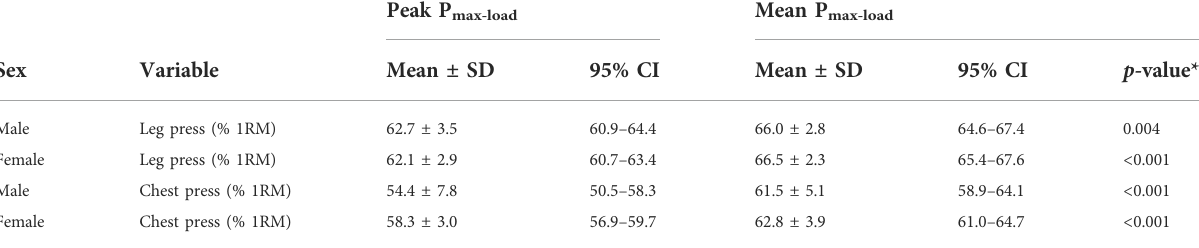
TABLE 3 Differences between peak P max-load vs. mean P max-load in the leg press and chest press in both